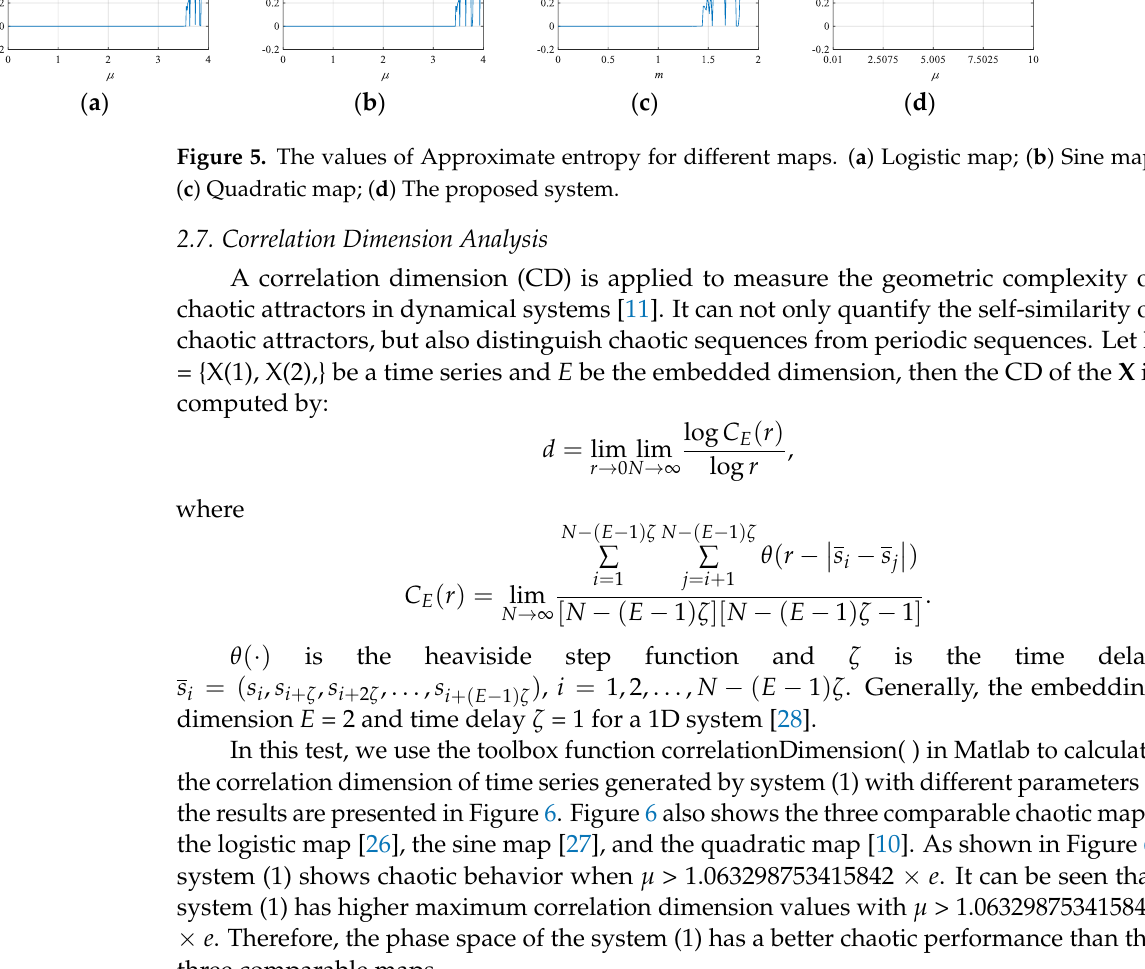
Figure 5. The values of Approximate entropy for different maps. ( a ) Logistic map; ( b ) Sine map; ( c )